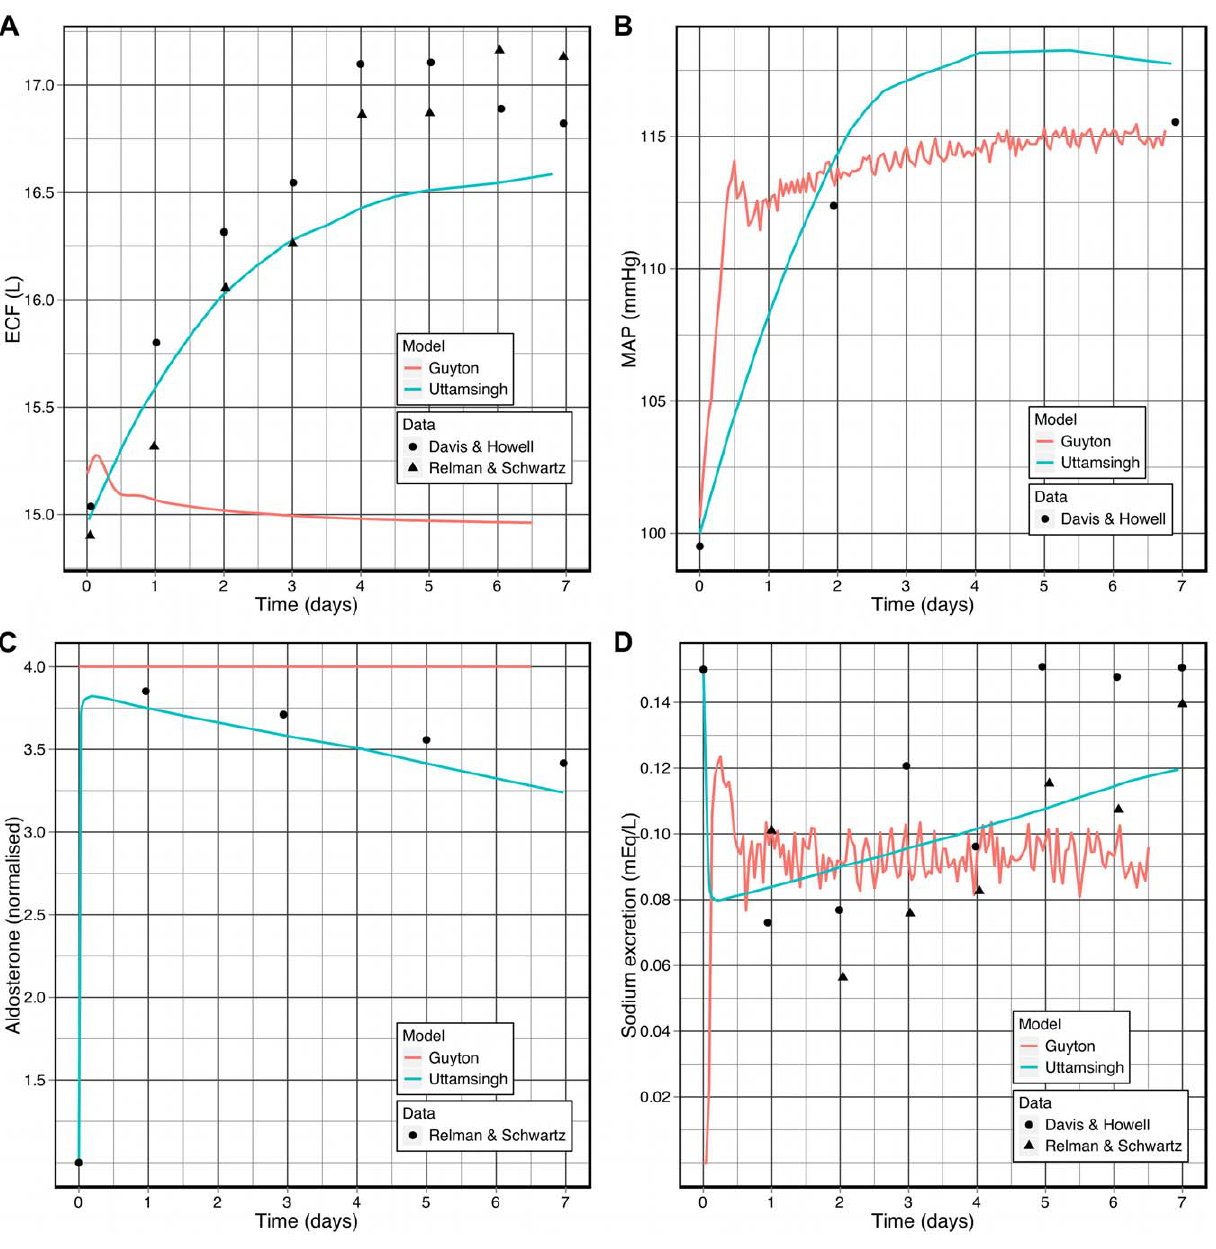
Figure 10. The effects of aldosterone loading on the human body. This simulation reproduced the conditions shown in Figure 5 of Uttamsingh et al. [74], which inclues experimental data from Davis and Howell [94] and Relman and Schwartz [76]. A: Extra-cellular fluid volume. B: Mean arterial pressure. C: Serum aldosterone (normalized). D: Sodium excretion rate.